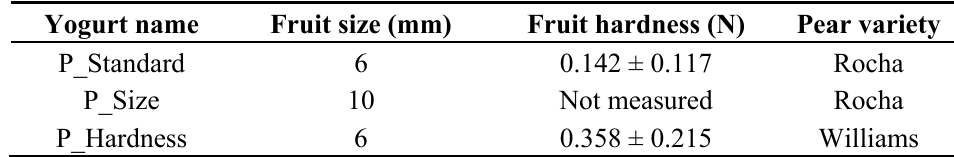
Table 1. Characteristics of fruit pieces in fruit preparations used in the three different